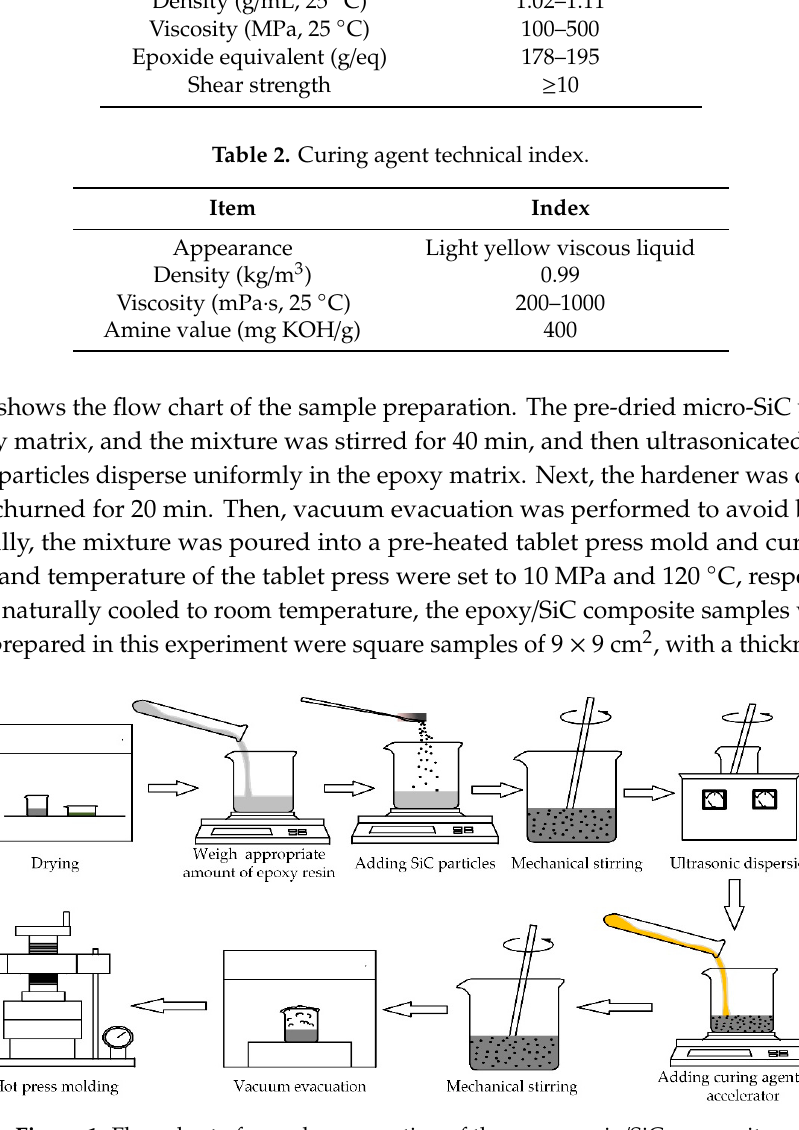
Figure 1. Flow chart of sample preparation of the epoxy resin / SiC composites.